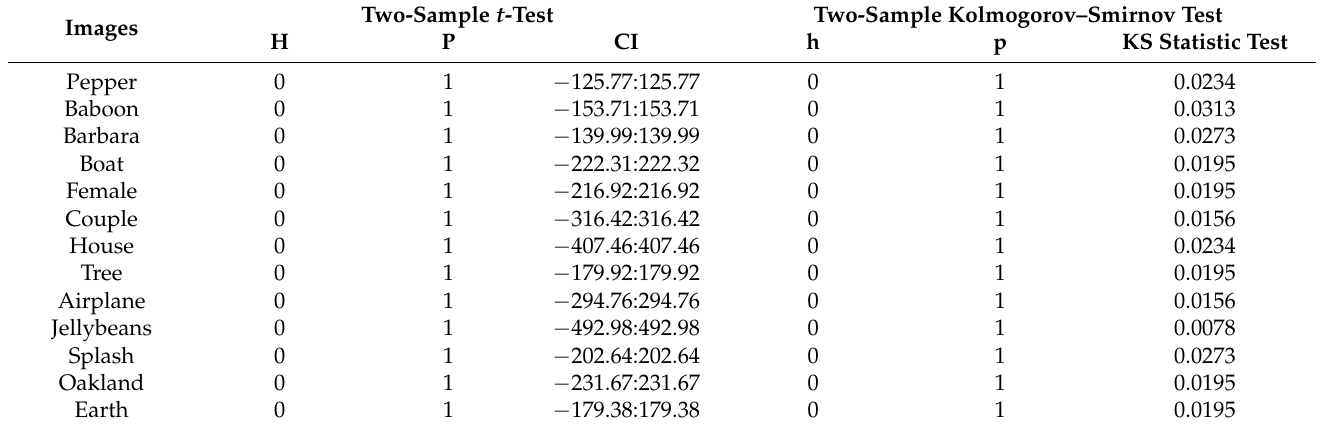
Table 6. Two-sample t -test and Kolmogorov–Smirnov test.